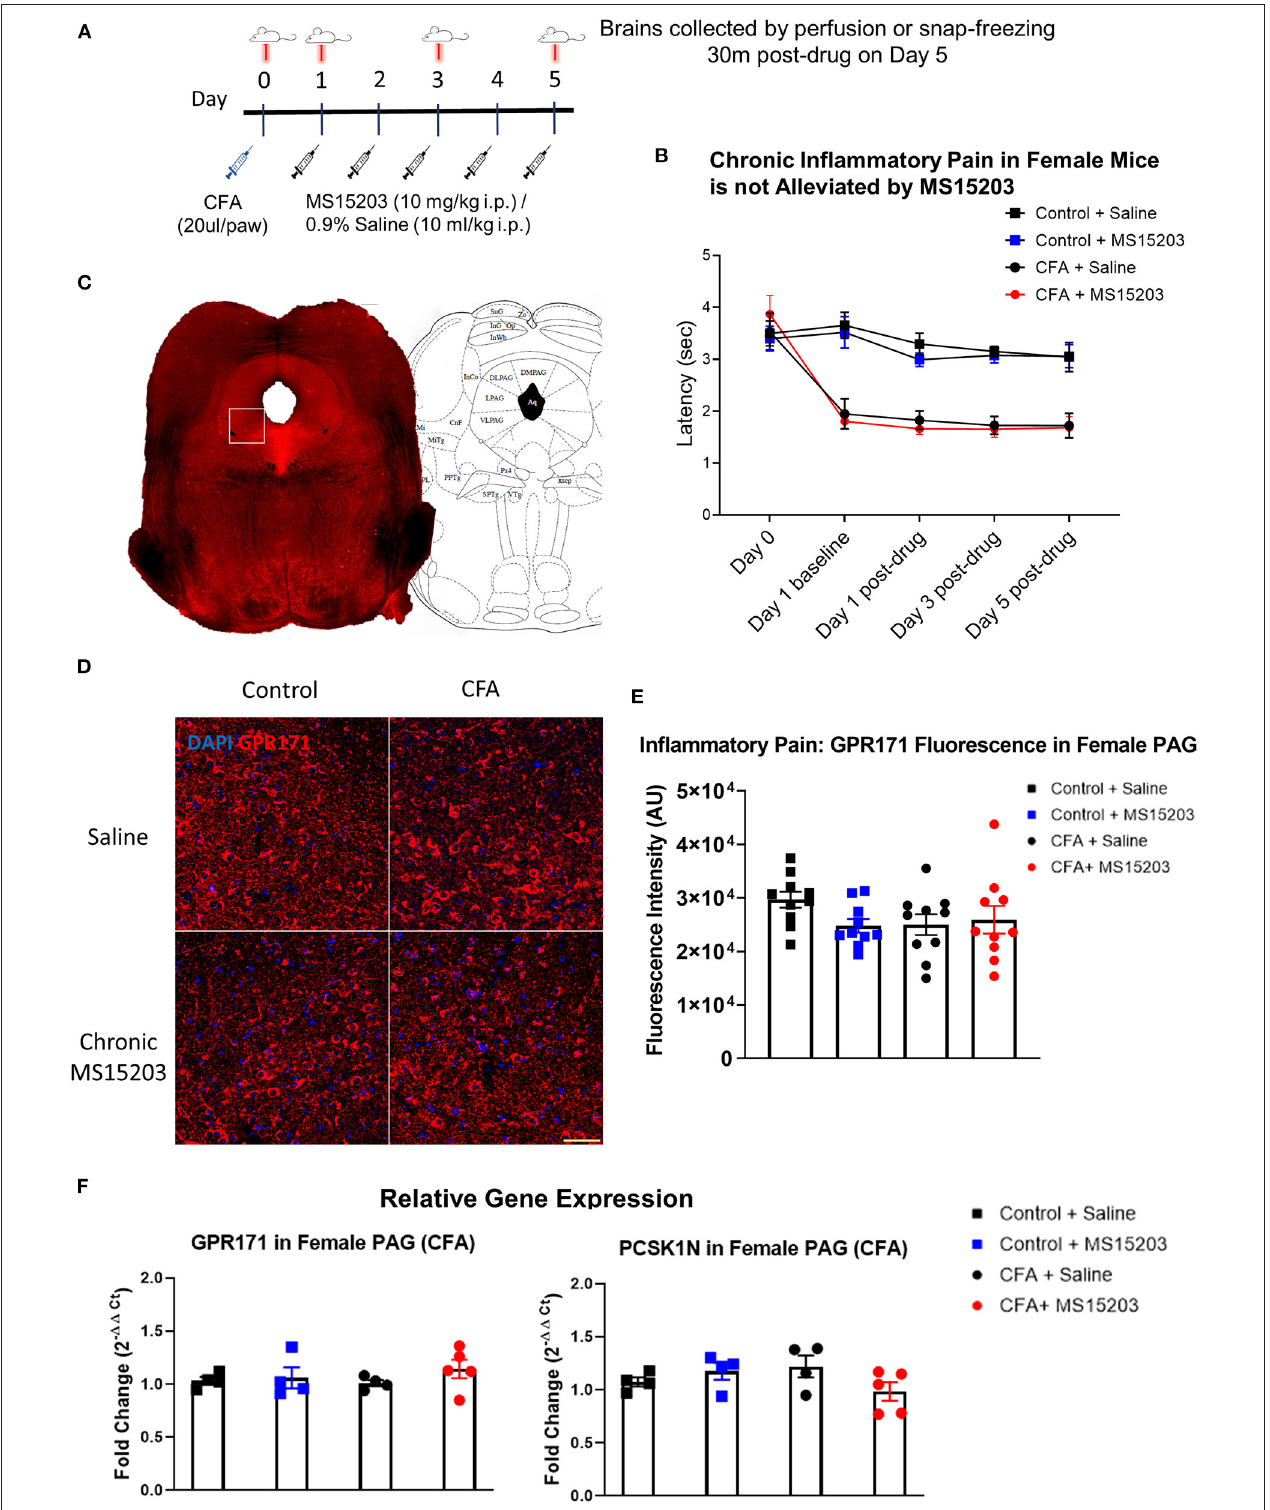
FIGURE 1 | MS15203 does not reduce chronic inflammatory pain in female mice. (A) An illustrative timeline describing the experimental design of CFA-induced inflammatory pain followed by MS15203 treatment. (B) Female mice ( n = 6–8/group) injected with CFA in their hind paws developed rapid thermal hypersensitivity as measured by a plantar test. Chronic treatment with MS15203 failed to alleviate inflammatory pain as noted by the persistence of thermal hypersensitivity